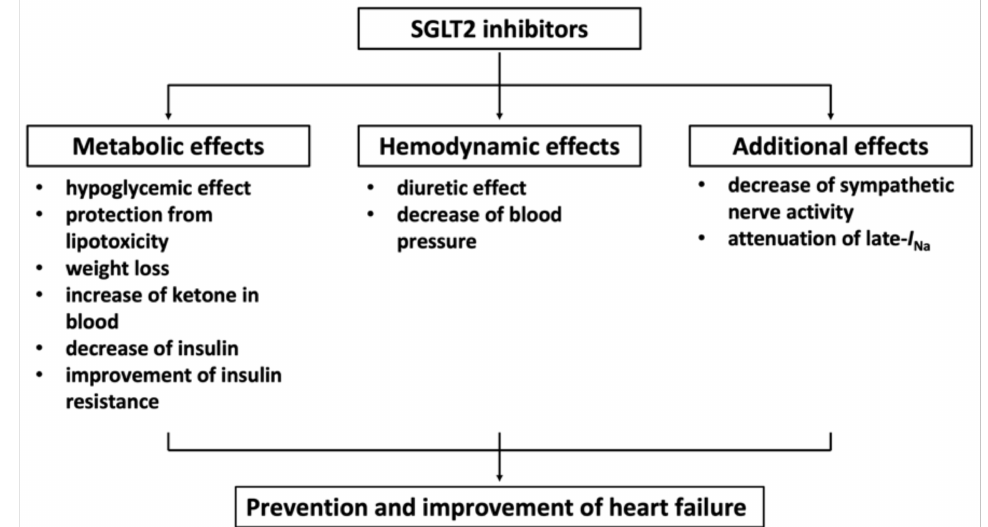
Figure 2. Mechanisms by which SGLT2 inhibitors prevent and improve heart failure. SGLT2, sodium glucose cotransporter 2; late- I Na , late component of the cardiac sodium channel